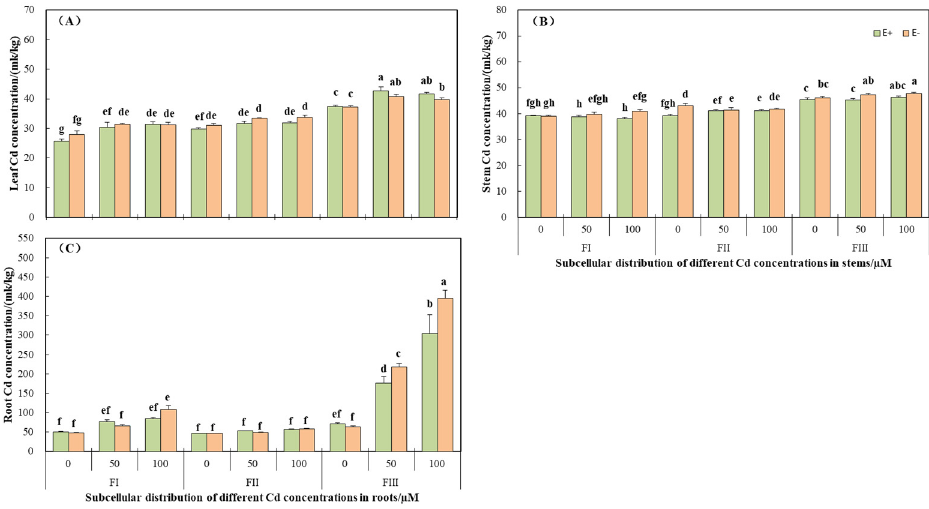
Figure 6. Subcellular distribution of Cd in leaves, stems, and roots of Hordeum brevisublatum . ( A ) Leaf, ( B ) Stem, and ( C ) Root. FI: cell wall component, FII: organelle fraction, FIII: soluble fraction, E+: endophyte-infected, and E − : endophyte-free. The values presented are mean ± standard error (SE). Lowercase letters (a–h) on top of the bars indicate significant differences ( p < 0.05) of E+ and E − plants under the different concentrations of CdCl 2 stress.